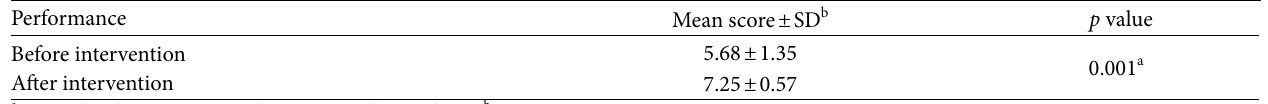
Table 6: Mean score of MDI before and after intervention.